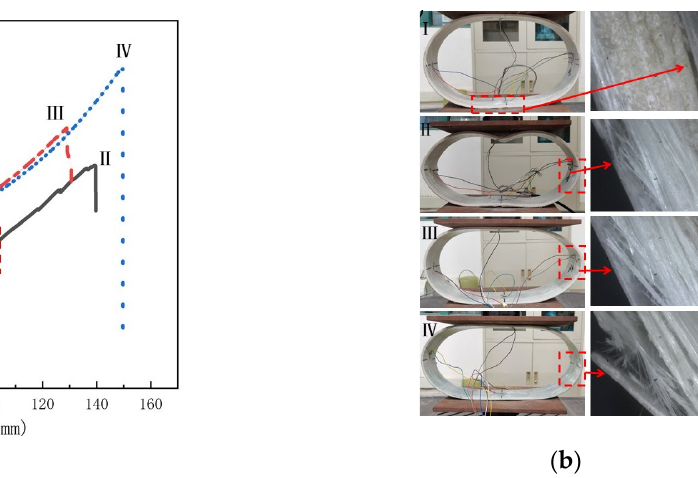
Figure 13. Load–displacement curves and failure mode diagrams for different types of GFRP pipes at 30 °C ( a ) Load–displacement curve for GFRP pipes; ( b ) Failure mode.